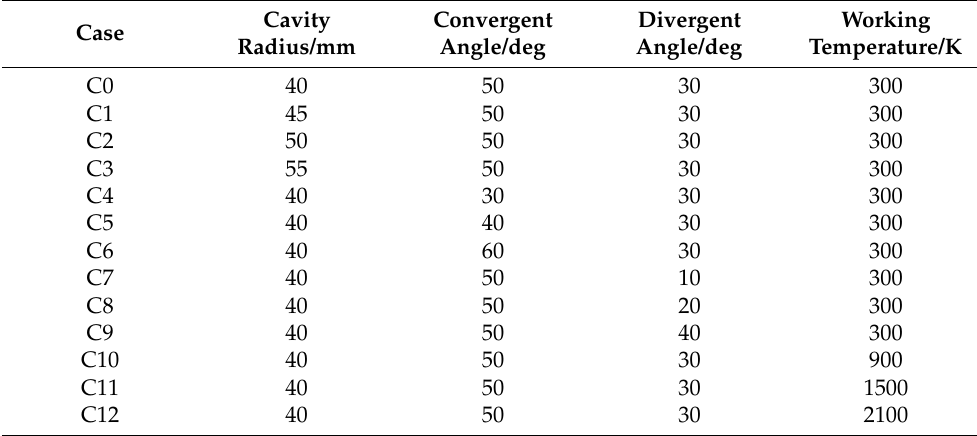
Table 5. Different cases studied in this